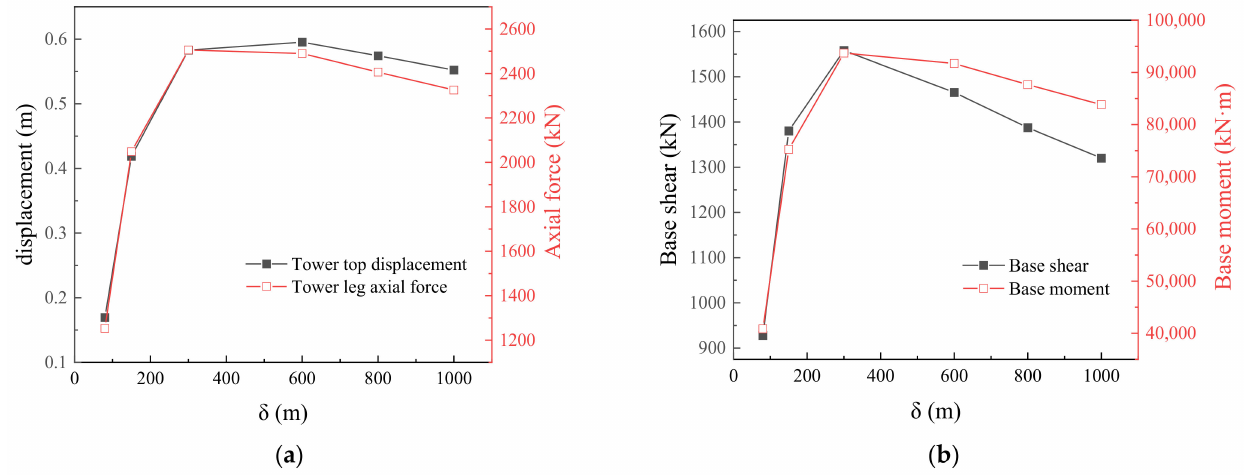
Figure 14. Wind-induced response of tower-line system changes with δ : ( a ) tower top displacement and tower leg axial force; ( b ) base shear and bending moment.